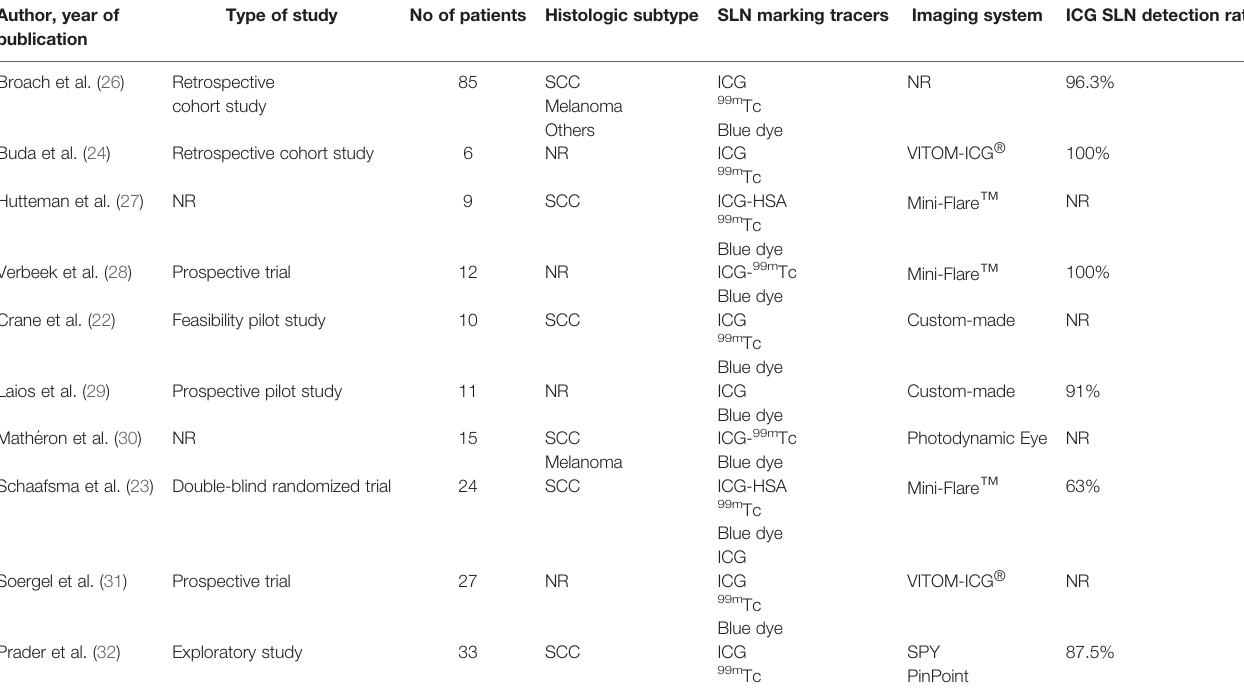
TABLE 4 | Studies using indocyanine green for sentinel lymph node mapping in vulvar cancer